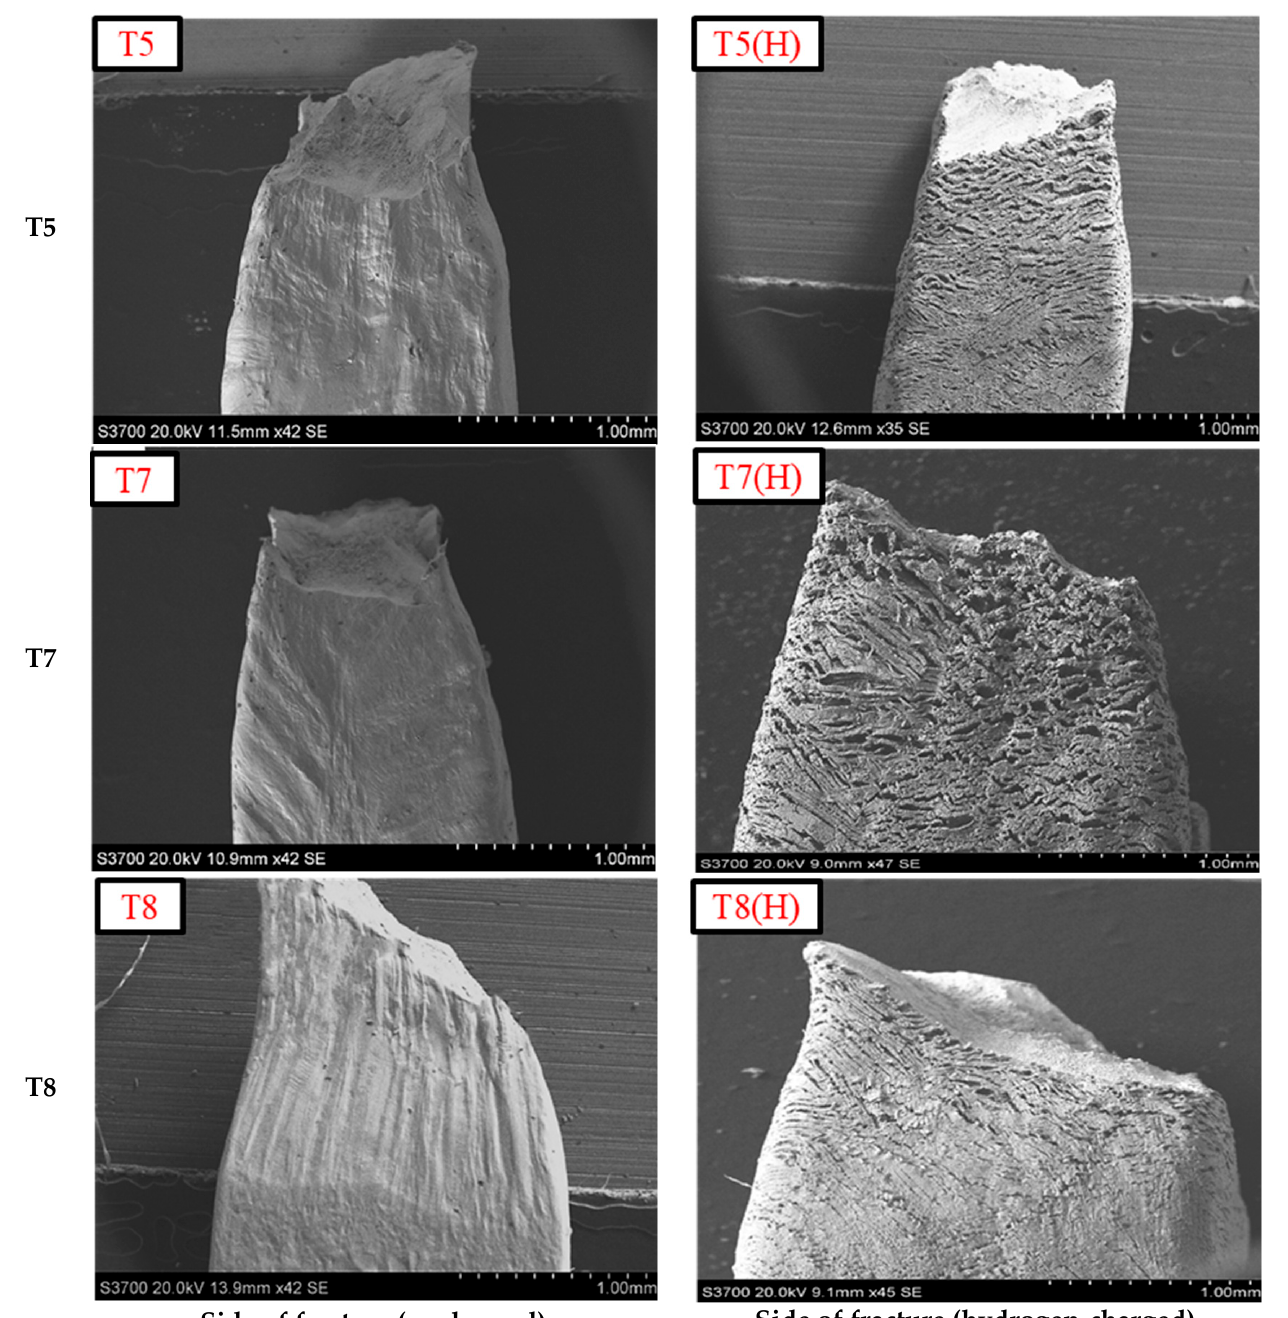
Figure 10. Morphology of TIG weld fractures before and after hydrogen charging (T1, T4, T5, T7 and T8 are uncharged specimen, T1(H), T4(H), T5(H), T7(H) and T8(H) are hydrogen pre-charged specimen).